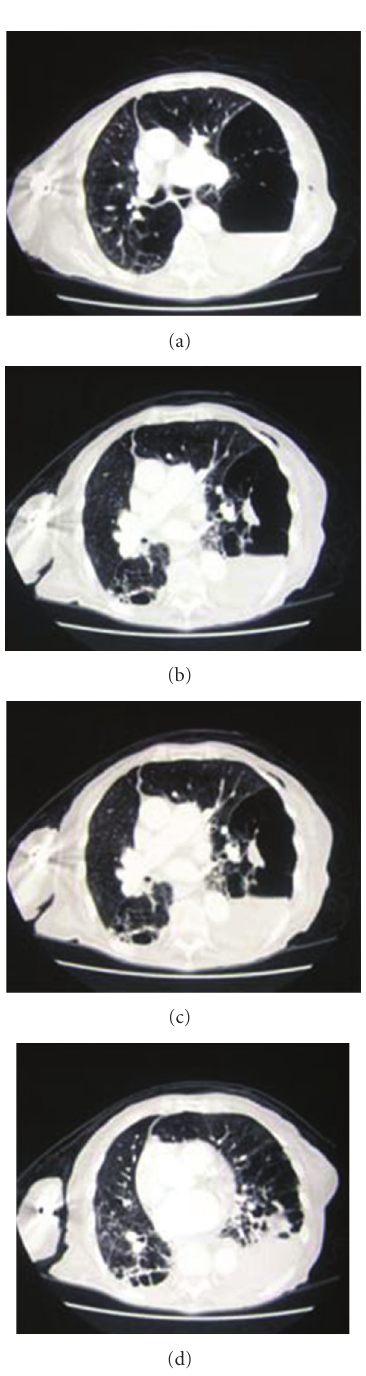
Figure 11: A CT scan on the same patient as in Figure 11 shows extensive bullous emphysema. The punctured bulla contains an